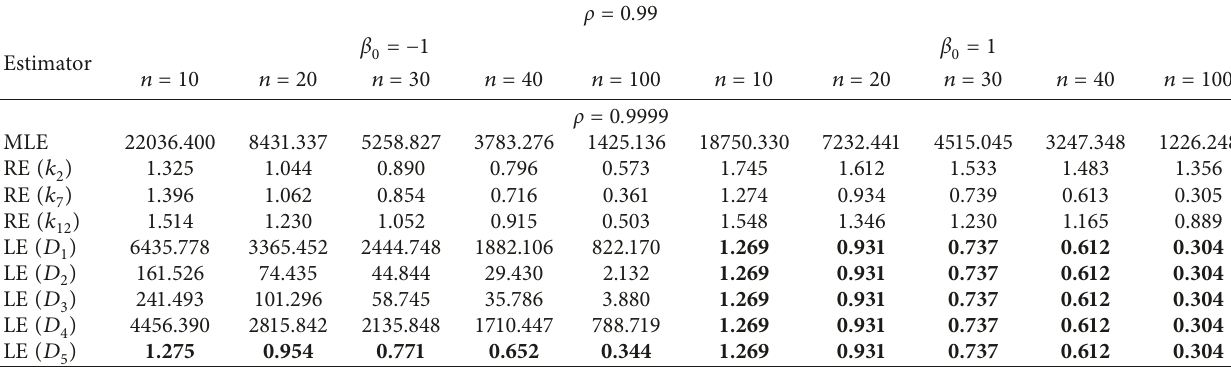
when δ � 0 . 02 , α � 0 . 03 , and p � 4. 0 ρ � 0 .